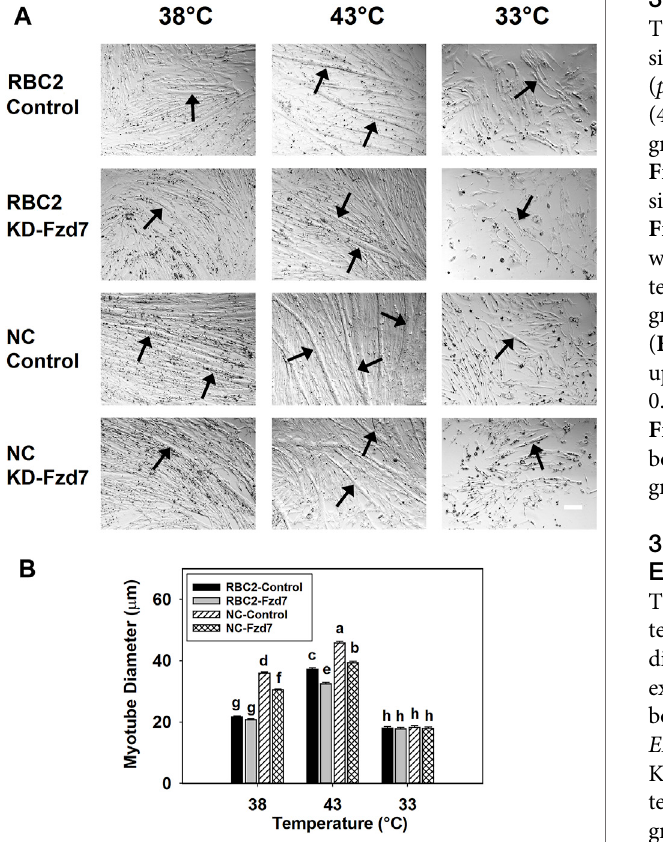
( p < 0.001, Figure 6A ) and 48 h of differentiation ( p < 0.001, Figure 6B ). With heat stress (43 ° C), PPAR γ expression decreased ( p < 0.001) in both lines with a greater reduction observed in the NC line compared to the RBC2 line at 72 h of proliferation ( Figure 6A ). In contrast, expression of PPAR γ was greatly increased with the cold stress (33 ° C), with the NC line showing a greater increase ( Figure 6A ). At 48 h of differentiation, PPAR γ expression increased ( p < 0.001) in both lines at 43 ° C but decreased at 33 ° C in the RBC2 line ( p < 0.001) ( Figure 6B ). Knockdown of Fzd7 downregulated ( p ≤ 0.002) expression of PPAR γ in both lines at both sampling times, with greater reductions (fold change) in the RBC2 line compared to the NC line at both 43 ° C and 33 ° C